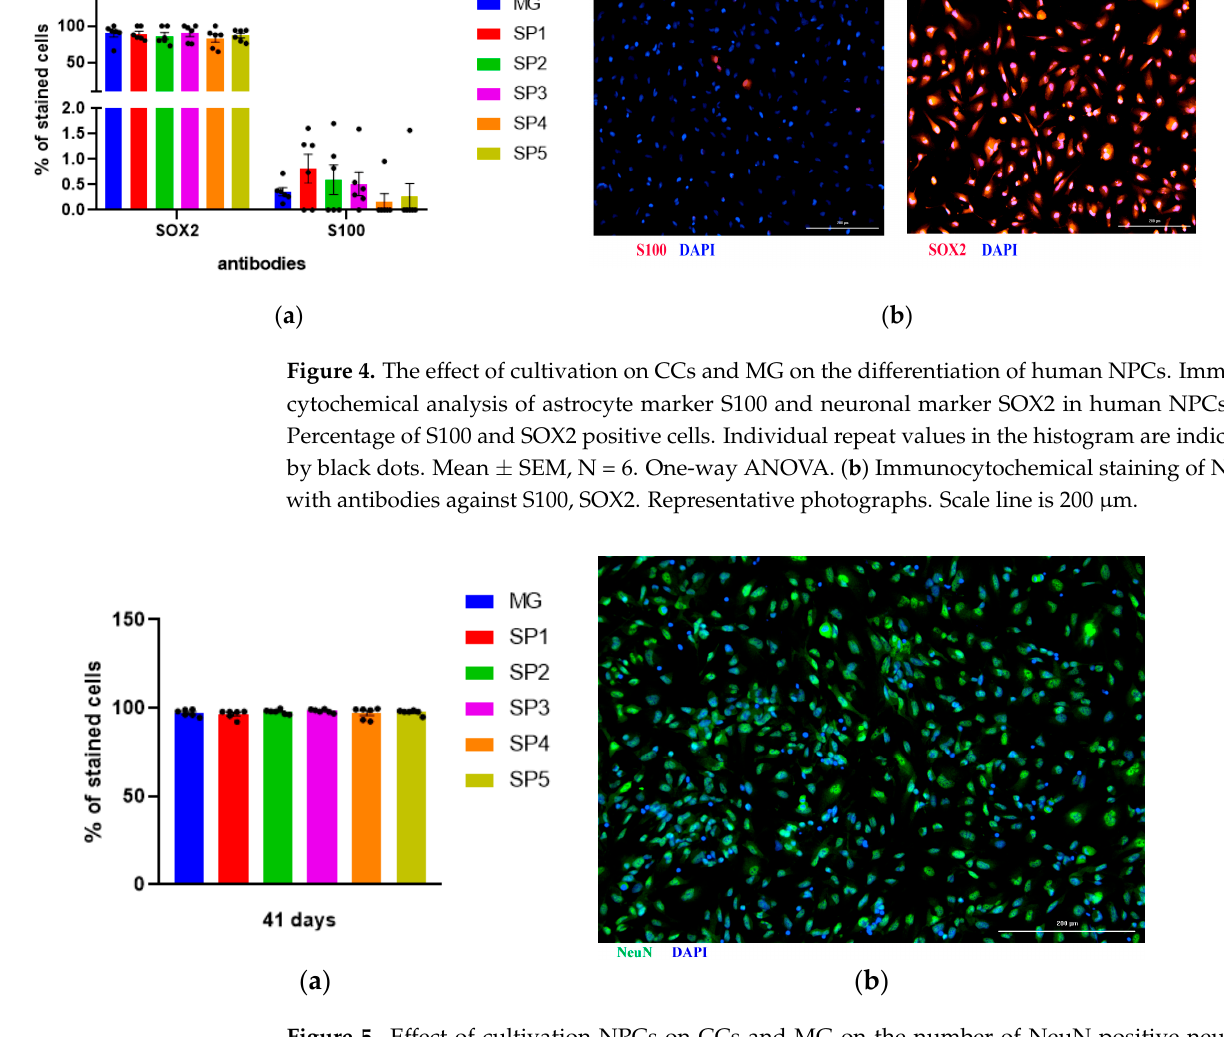
Figure 5. Effect of cultivation NPCs on CCs and MG on the number of NeuN-positive neurons produced. ( a ) Percentage of NeuN positive cells. Individual repeat values in the histogram are indicated by black dots. One-way ANOVA. Mean ± SEM, N = 6. ( b ) IDN immunocytochemical staining with antibodies against NeuN. Representative photographs. Scale line is 200 μ m.